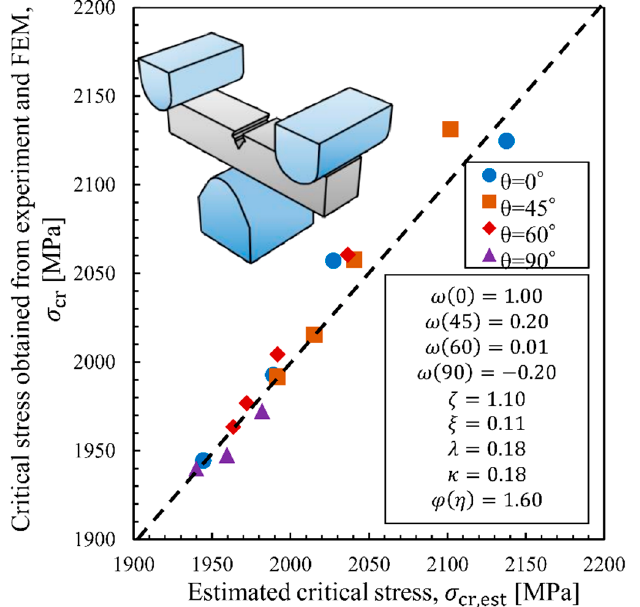
Figure 11. Accuracy of the proposed formula established to estimate critical stress.